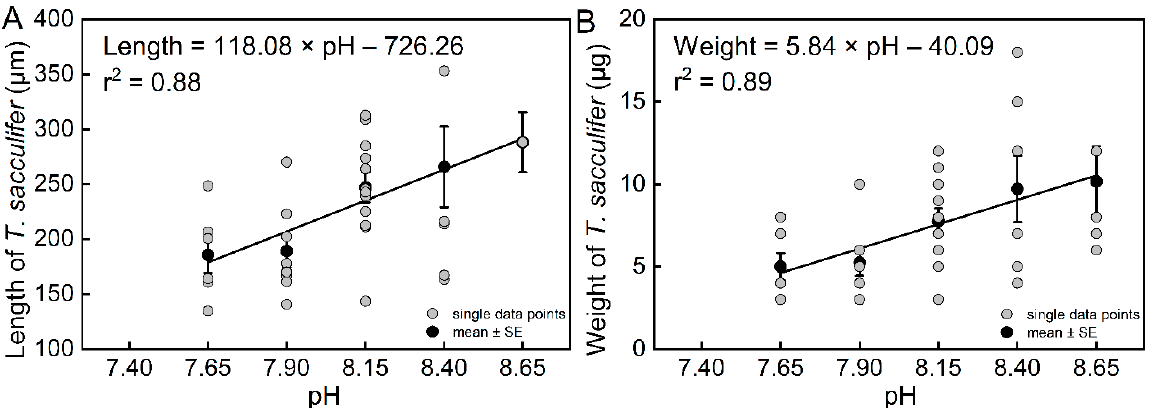
Figure 4. The relationships between length ( A ) and weight ( B ) of T. sacculifer versus seawater pH. Note: There were no living T. sacculifer under the pH 7.40 treatment, and data from this treatment were not analyzed for regression. Error bar = SE. Similar to the growth rate in the previous section, there was high variability due to the relatively small sample sizes.